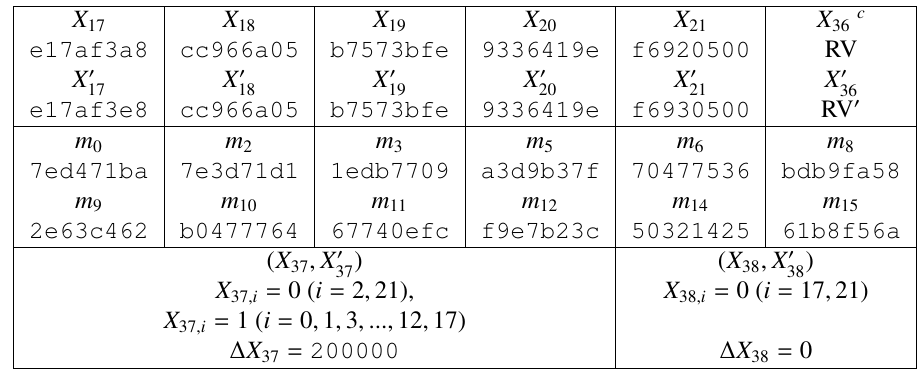
Table 5: An Example of the 17-38 Steps Di ff erential Path in the Left